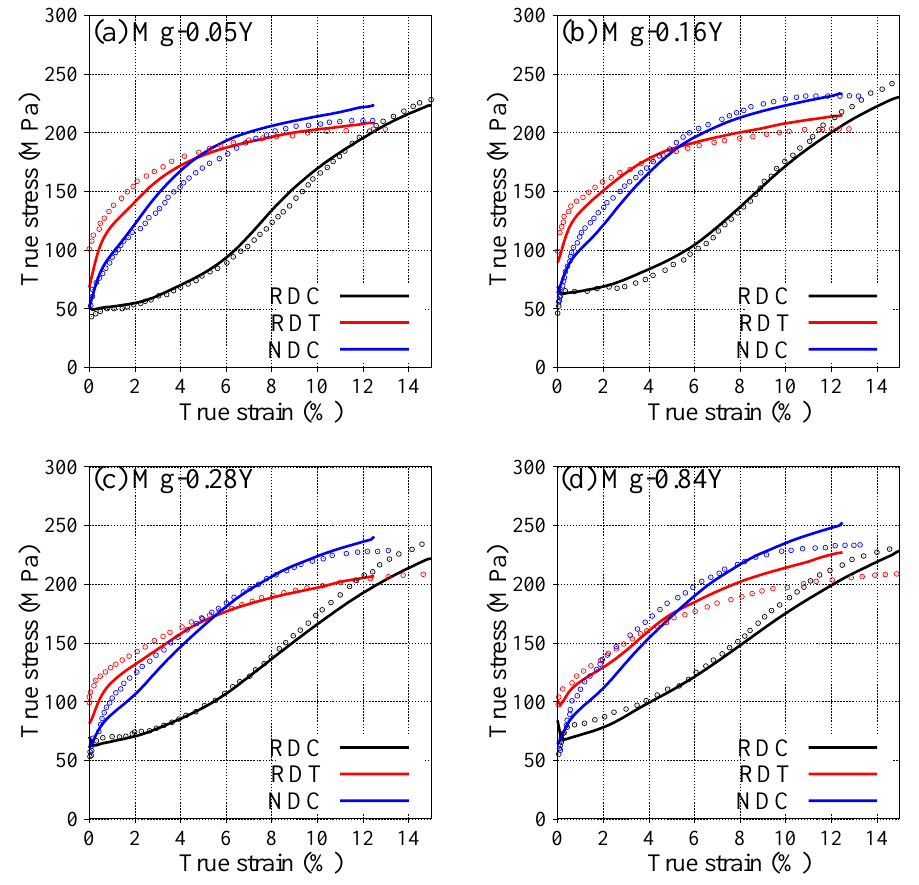
Figure 1. Model (solid)-predicted stress–strain response for all three loadings (RDC, RDT, and NDC) along with the experimental data (symbols) for ( a ) Mg-0.05%Y, ( b ) Mg-0.16%Y, ( c ) Mg-0.28%Y, and ( d ) Mg-0.84%Y alloy. Here, RDC, RDT, and NDC refer to the rolling direction compression, rolling direction tension, and normal direction compression, respectively. Experimental values are taken from [69]. Only Mg-0.16Y and Mg-0.84Y alloys are used for model calibration and other two cases are used for model validation.